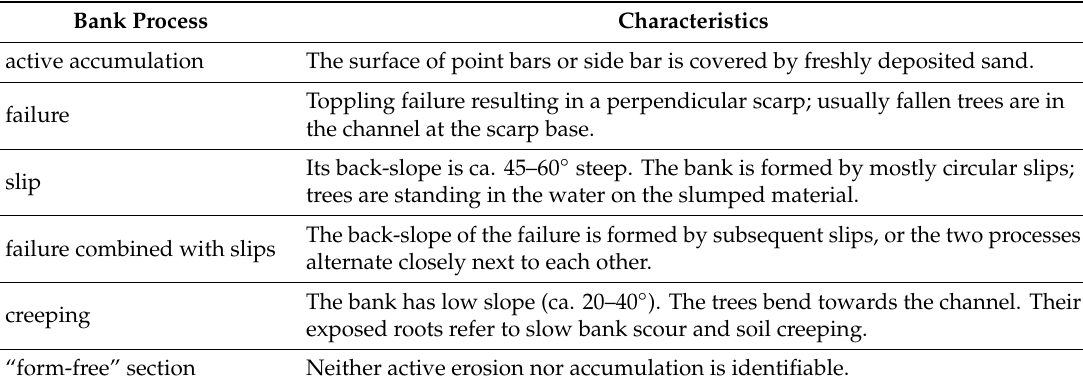
Table 1. Characteristics of the identified and mapped bank-forming